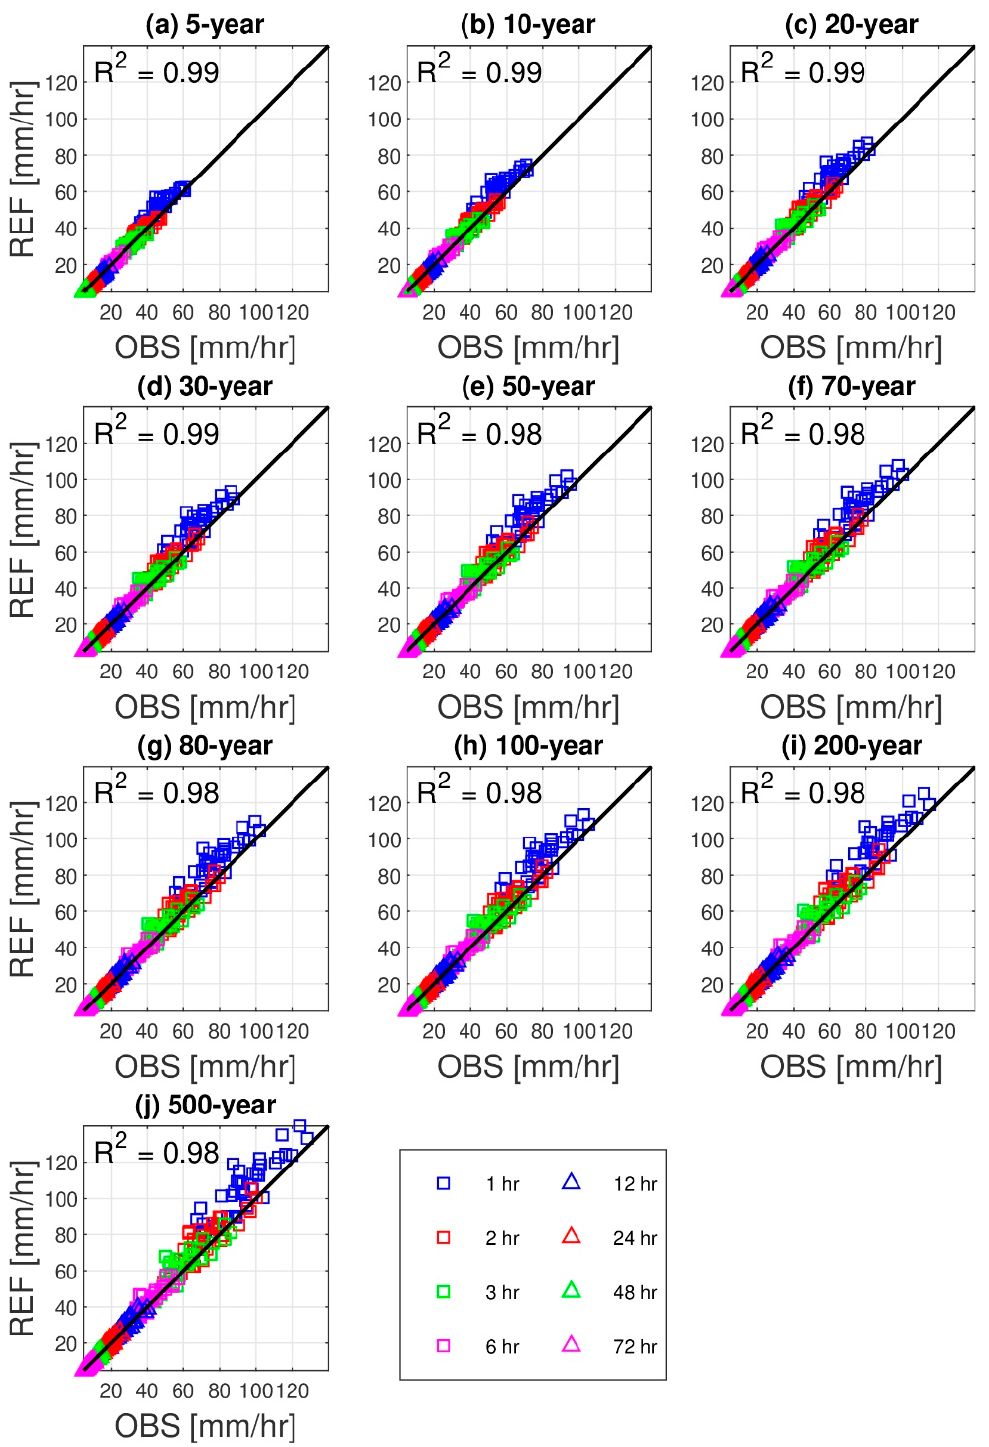
Figure 2. Comparisons of rainfall frequency estimates computed from observation (OBS), from 1981 to 2010 with the reference estimates published by Korean government in the Korea Precipitation Frequency Data Server (REF) for 8 durations and 10 return periods. The number of data points in each subplot is 320 (40 locations × 8 durations). Gumbel distribution and maximum likelihood estimation method are used for both results.